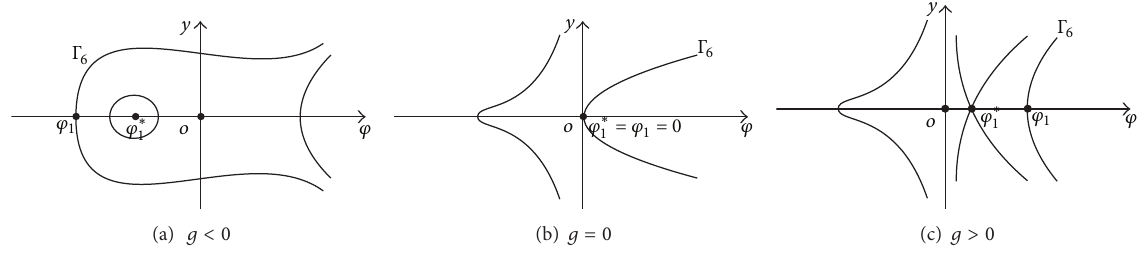
Figure 10: The phase portraits of system (43) when 𝑐 < 0